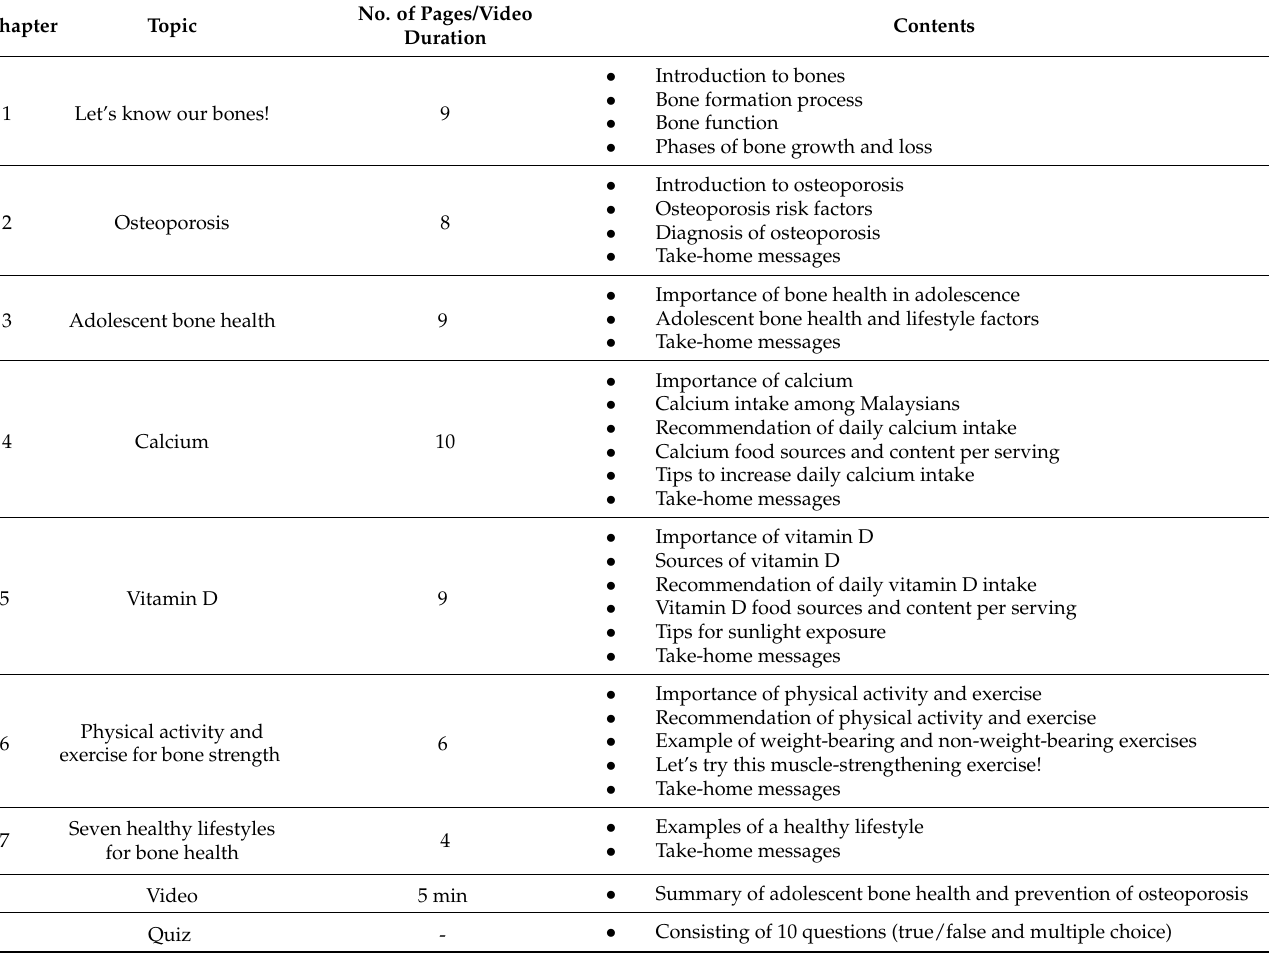
Table 4. Summary of the e-book contents for adolescent bone health and osteoporosis educational material.